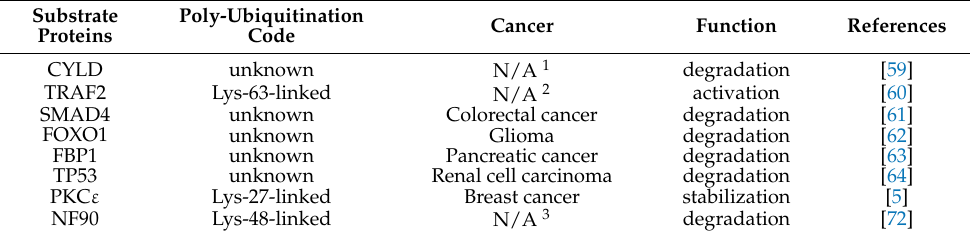
Table 2. Substrates of